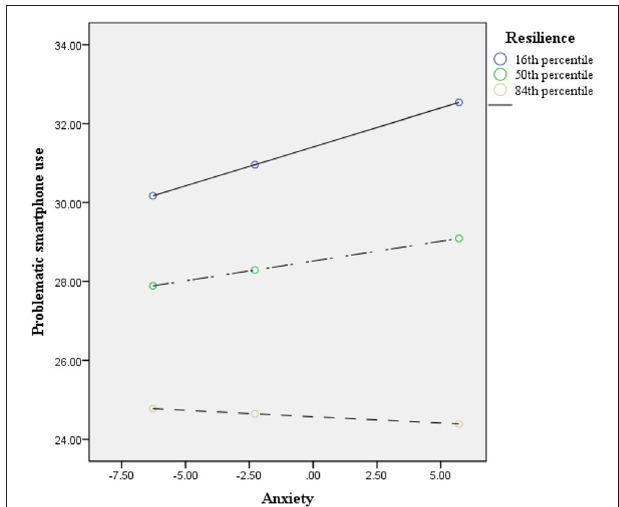
FIGURE 4 | The conditional effect between anxiety and problematic smartphone use ( N = 748). To further understand the moderation effect of resilience on the path between anxiety and problematic smartphone use, a conditional indirect effect analysis was conducted at 16th, 50 th , and 84th percentiles resilience.